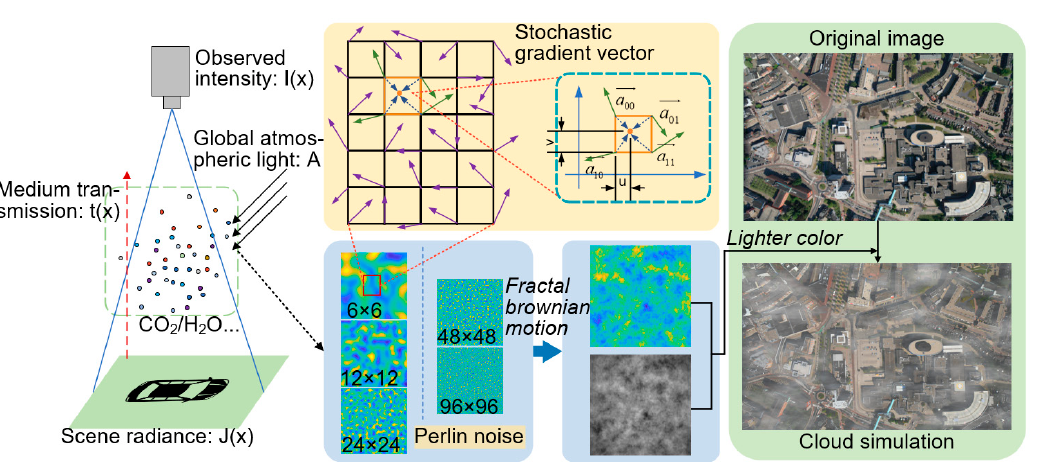
Figure 3. Schematic diagram of the haze simulation process.